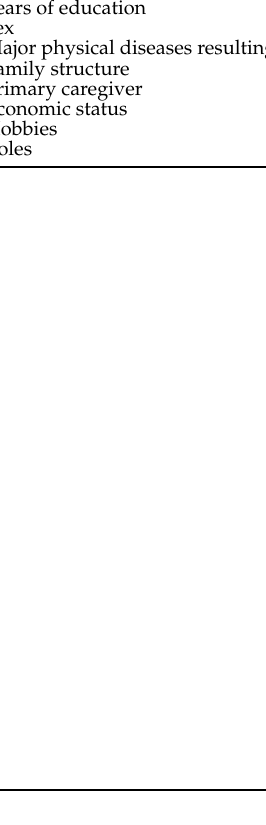
Table 2. Results of single regression analysis: contextual factors affecting empowerment (N = 151). Independent Variable B SE B β t Value